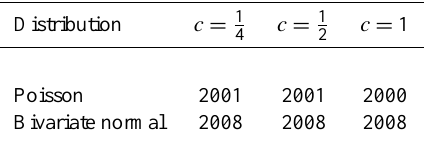
Table 4. Atlantic tropical storm data from 1951 to 2008 are used to detect any mean change in tropical storm characteristics. Here c is the magnitude representing the number of standard deviation from the mean. The result shows that the number of tropical storm had a significant increase around the year of 2000, and strength of the tropical storm has not changed. Figure 3. A moving average estimate of the average number of trop- ical storms between 1951 and